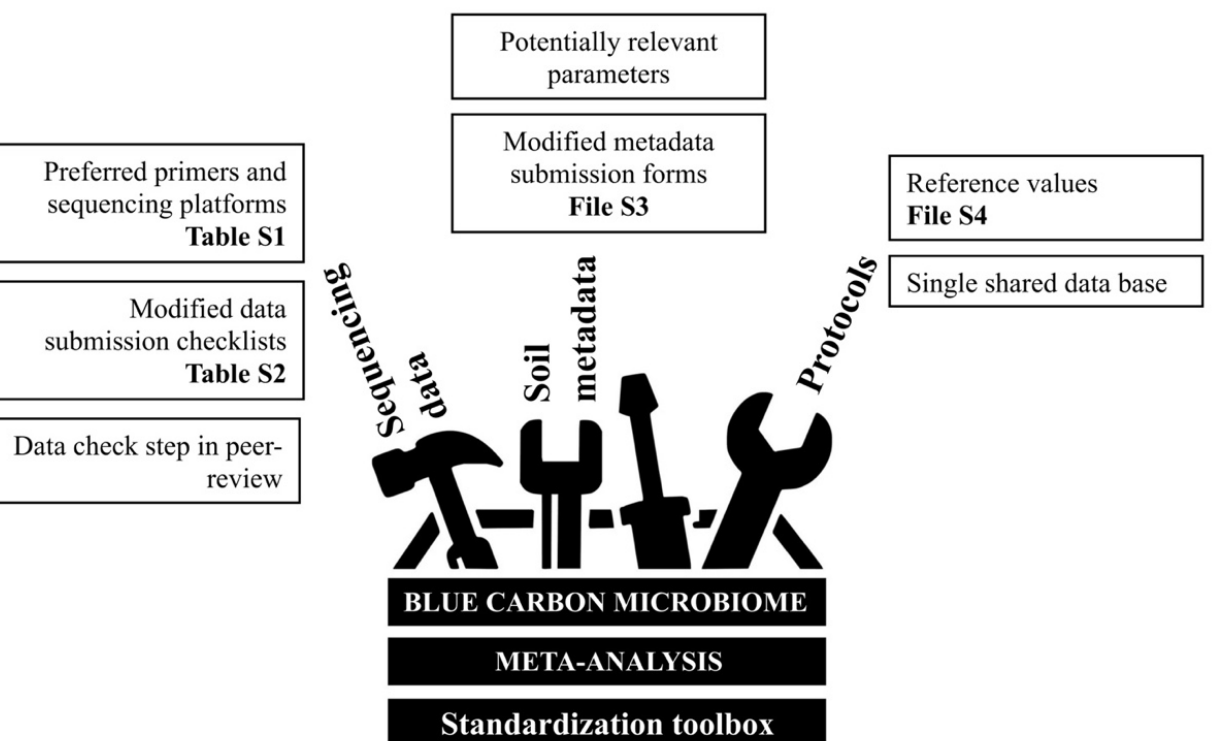
Figure 3. Proposed enacting tasks toolbox. General approaches have been previously suggested to solve methodological barriers to conduct a synthesis or meta-analysis on existing data. Here, we propose ways to improve them using more tangible resources that support enacting tasks. Tasks are clustered into three categories, each responding to the methodological constrains listed in Table 1, and could be actioned in any order. Standardisation tools supporting each task are provided in the Supplementary Materials.